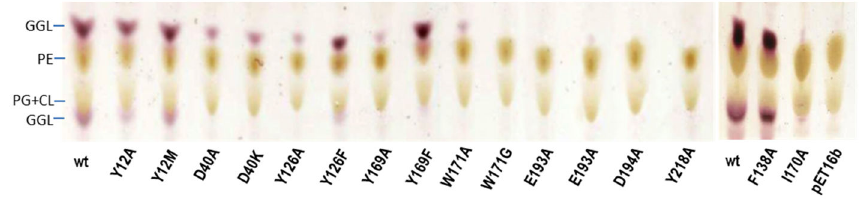
Figure 6. TLC analysis of lipid extracts from recombinant E. coli cells expressing MG517 mutants. GGL, glycoglycerolipids; PE, phosphatidylethanolamine; PG: phosphatidylglycerol; CL: cardiolipine. pET16b are control cells transformed with plasmid pET16b with no